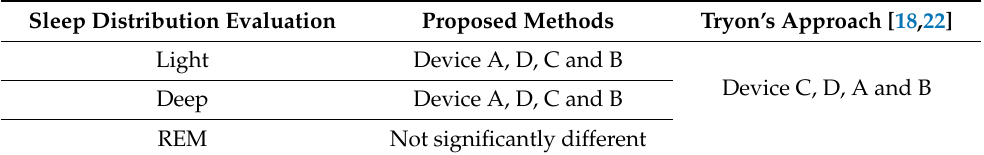
Table 10. Comparison between the proposed method and Tryon’s approach on evaluating sleep distribution feature with the ranking according to the accuracy with